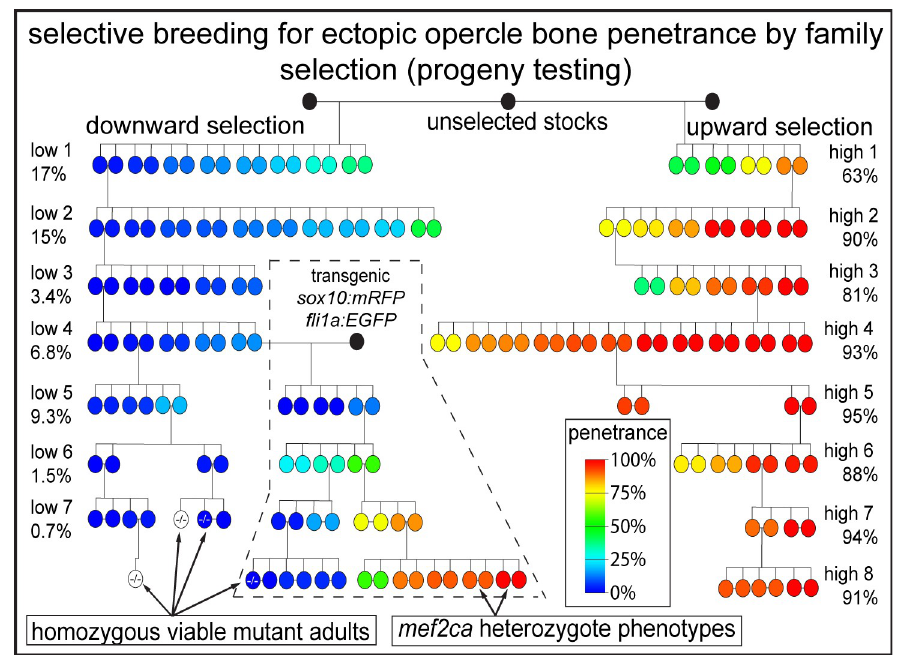
Fig 1. Selective breeding drives ectopic bone penetrance downward and upward. Full-sibling heterozygous mef2ca pairs were intercrossed and their homozygous mutant offspring were scored for penetrance of ectopic bone near the opercle. Mutant progeny penetrance scores were assigned to each breeding pair. Parents are color coded for offspring penetrance on this pedigree. Heterozygous offspring from selected pairs were raised for the next round of selection. A single low-penetrance individual from generation four was crossed to a double-transgenic mef2ca wild-type unselected individual (black circle). Indicated individuals from recent generations in the low-penetrance line are viable as mef2ca homozygous mutants. Indicated pairs from recent generations in the high-penetrance strain produce heterozygous offspring with mef2ca -associated phenotypes. Uncolored circles represent homozygous mutant adults that were recovered but were not tested for mutant offspring ectopic bone phenotype